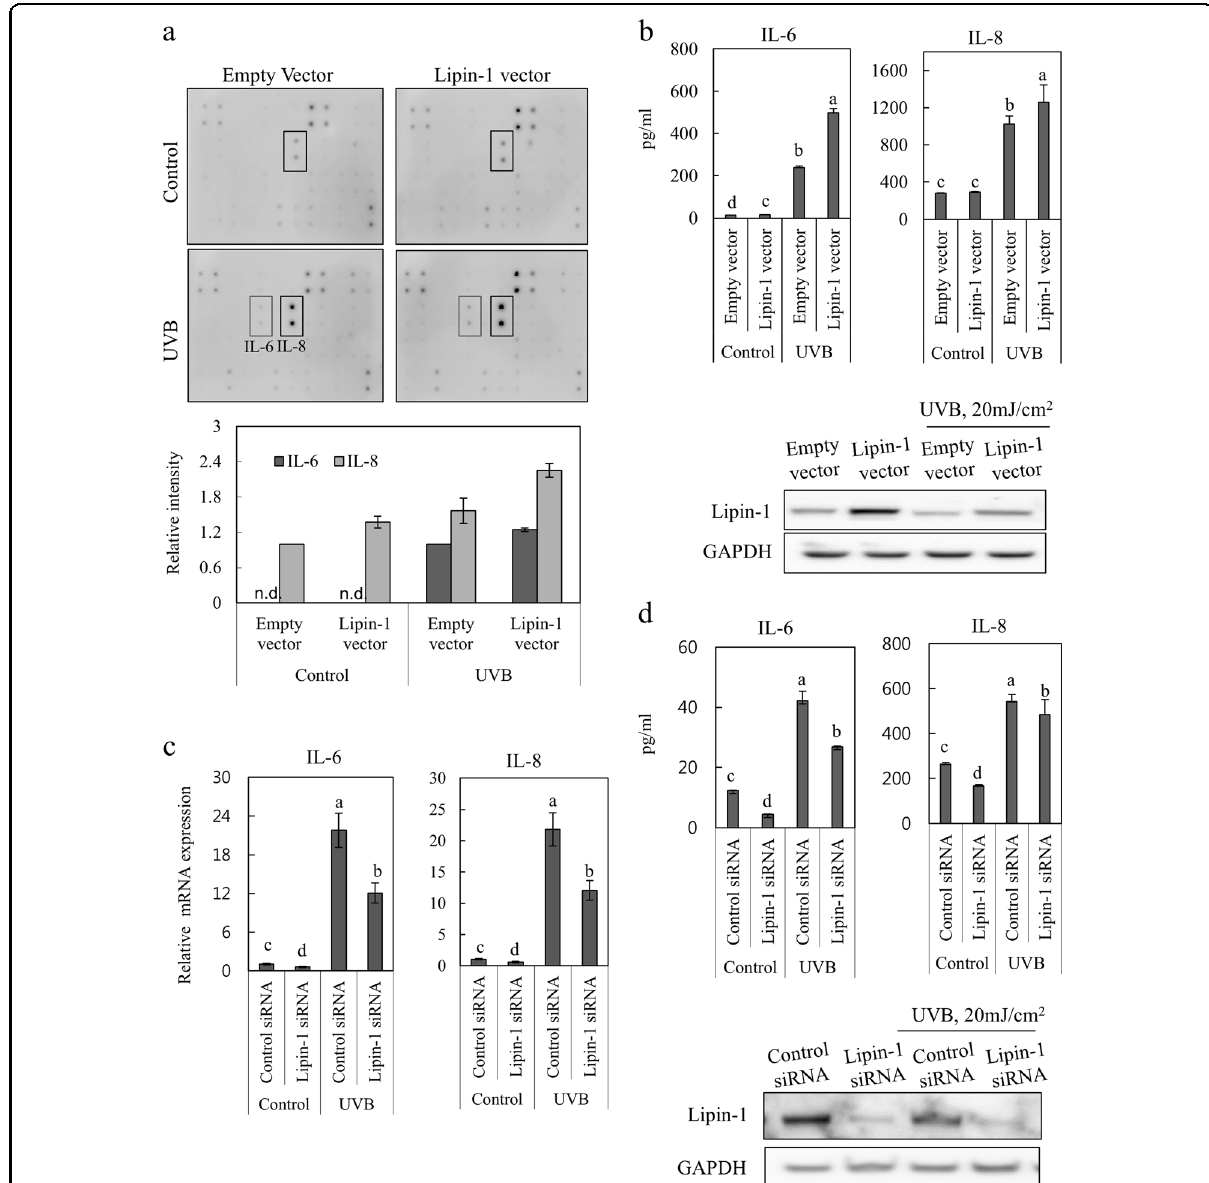
Fig. 5 UVB-dependent lipin-1 downregulation attenuates UVB-induced IL-6 and IL-8 production. NHEKs that were transfected with the vector containing lipin-1 cDNA or pCMV-AC empty vector were exposed to 20 mJ/cm 2 UVB and cultured for 24 h. a Culture media were harvested for cytokine array analysis. Representative altered spots were analyzed via densitometry. The data are presented as the mean ± SD values of the intensities of spots in two independent experiments. b Cell lysates were subjected to immunoblot analysis to con fi rm lipin-1 overexpression. Secreted IL-6 and IL-8 were detected in culture supernatants using speci fi c ELISA kits. c NHEKs that were transfected with lipin-1 or control siRNA for 24 h were exposed to 20 mJ/cm 2 UVB and cultured for 24 h. Total RNA was extracted from cells, and relative mRNA levels of IL-6 and IL-8 were measured via qRT-PCR. d Cell lysates were subjected to immunoblot analysis to con fi rm lipin-1 knockdown. The culture media were harvested, and IL-6 and IL-8 levels were detected via speci fi c ELISA kits. b – d The data (mean± SD) represent three independent experiments. Means without a common letter differ; P <